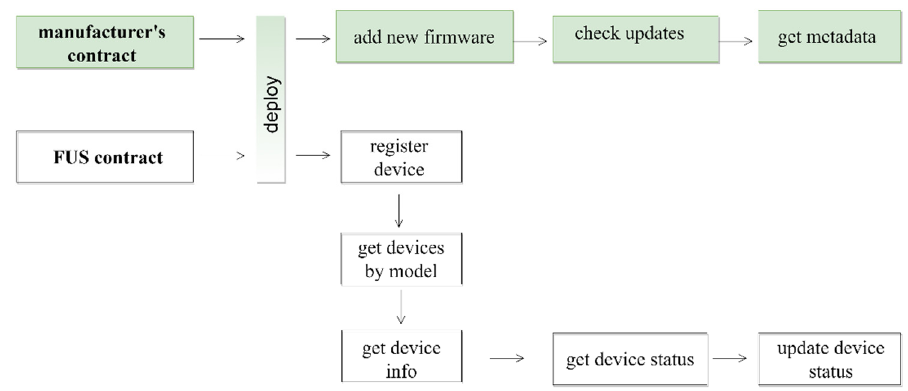
Figure 4. Proposed Smart Contract Functionalities.